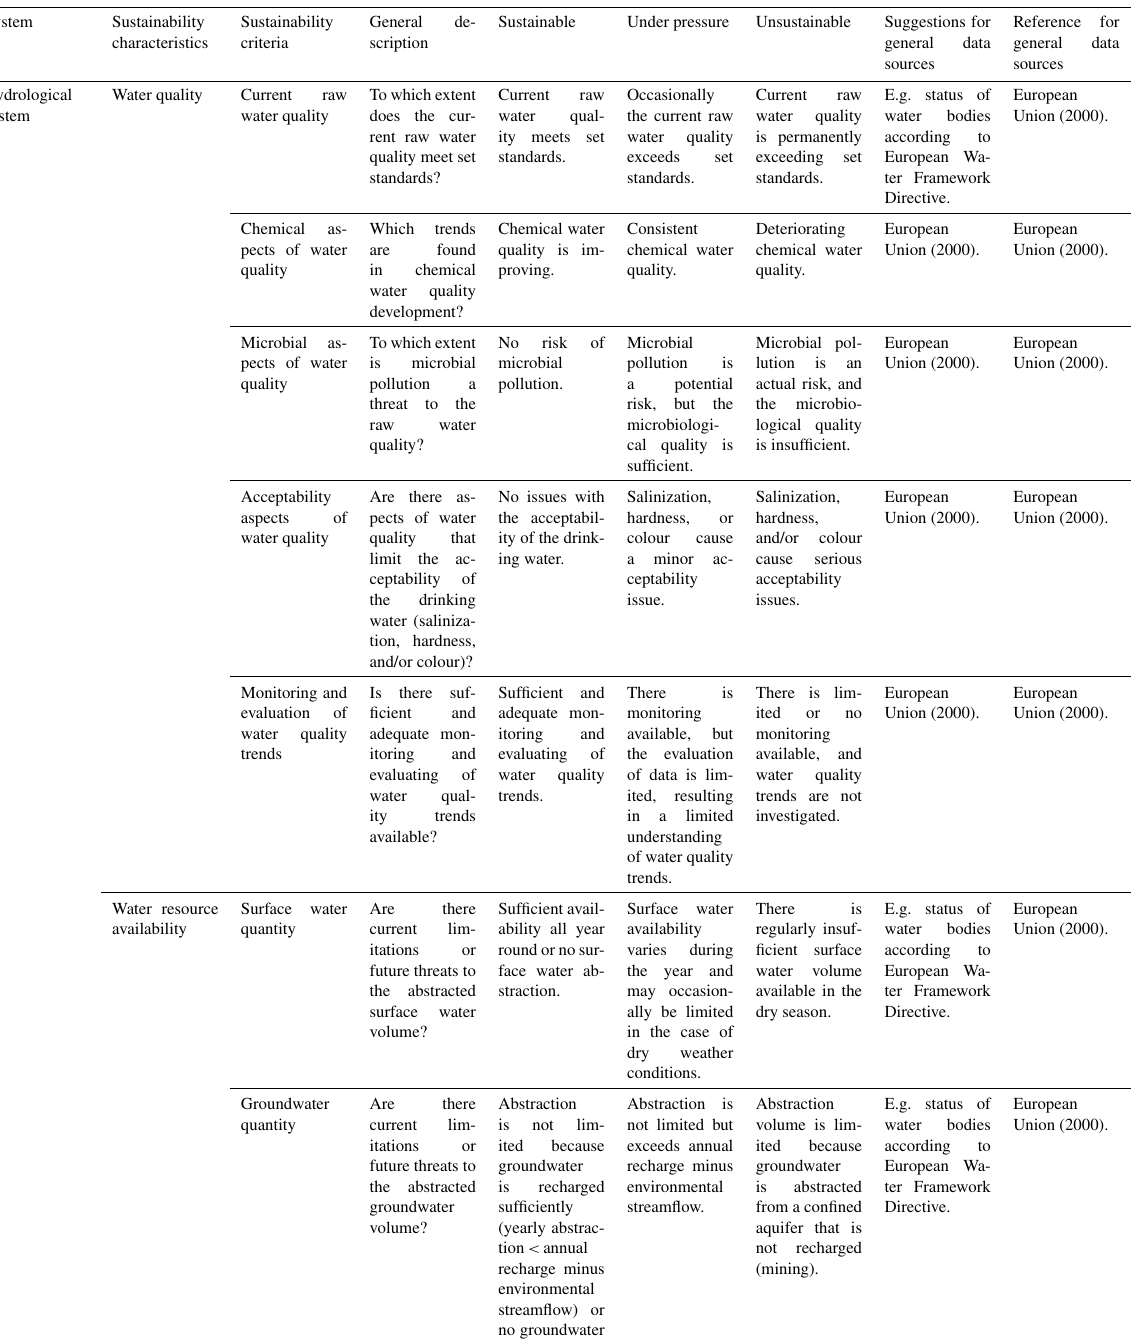
Table E1. Summarizes the hydrological, technical, and socio-economic sustainability characteristics and criteria for a local drinking water supply system from Sect.